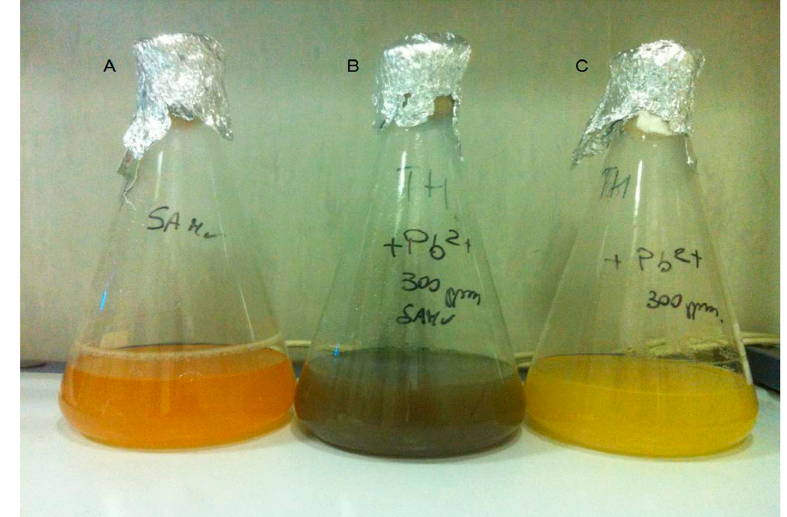
Figure 2. T. thermophilus growth at 75 °C with 300 ppm of Pb 2+ and without presence of Pb after 48 h